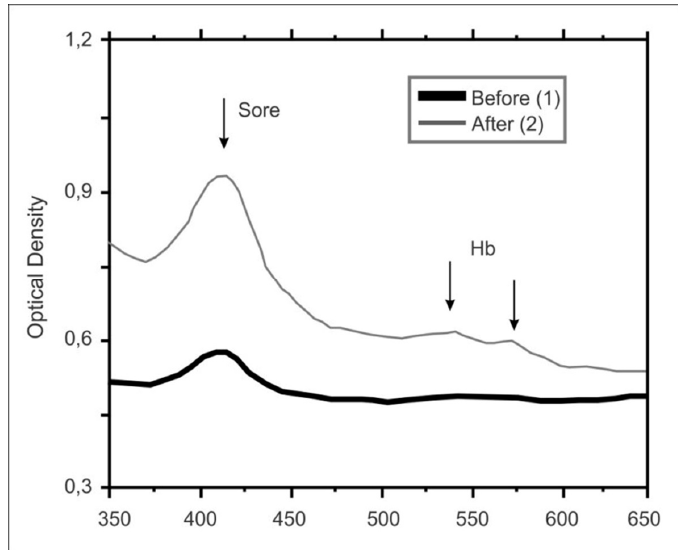
Figure 2. Absorption spectra of blood smears before and after addition of Acyzol (registration using the method of bio-crystallization of Acyzol (1:1500 and 1:3000) with the blood) [with permission from 95]. Annotation: 1) absorption spectra of a blood smear of a healthy donor. 2) absorption spectra of a blood smear after supplementation of Acyzol.